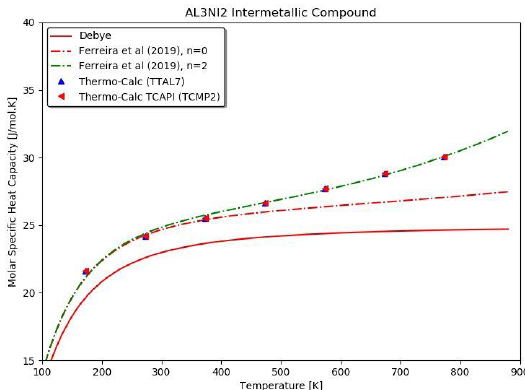
Figure 9. Comparison of the molar heat capacity of the AL3NI2 phase by carrying out Debye, Thermo-Calc, and Thermo-Calc TCAPI5 simulations and Ferreira‘s model 17 .